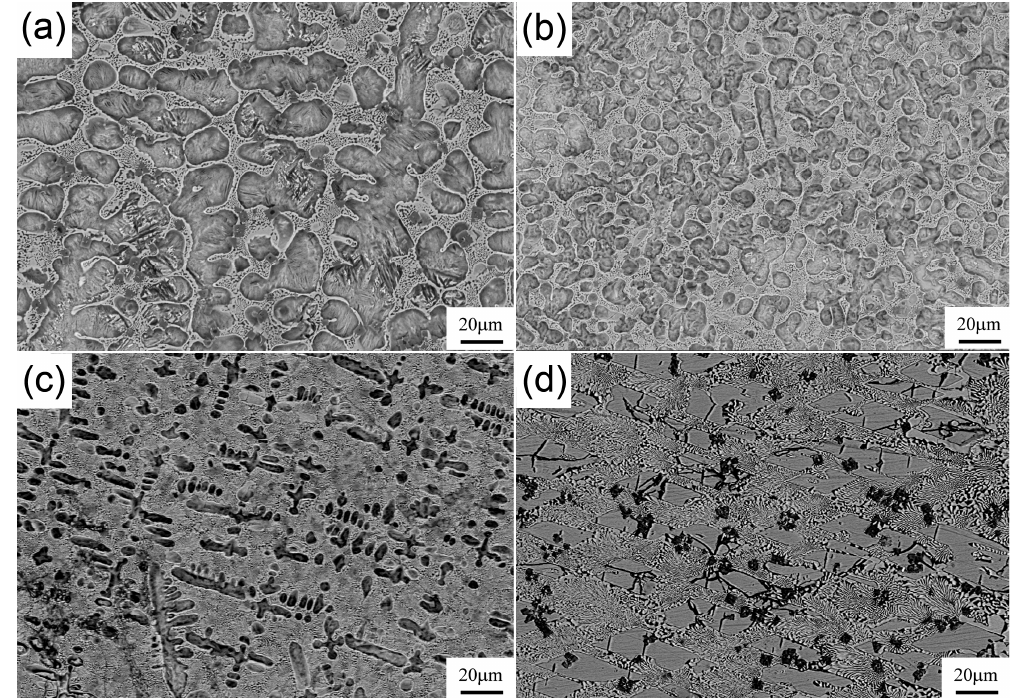
Figure 2. SEM images showing microstructure of the hardfacing layers with different of B additions: ( a ) 1.71%, ( b ) 3.42%, ( c ) 5.10%, and ( d ) 6.85%.